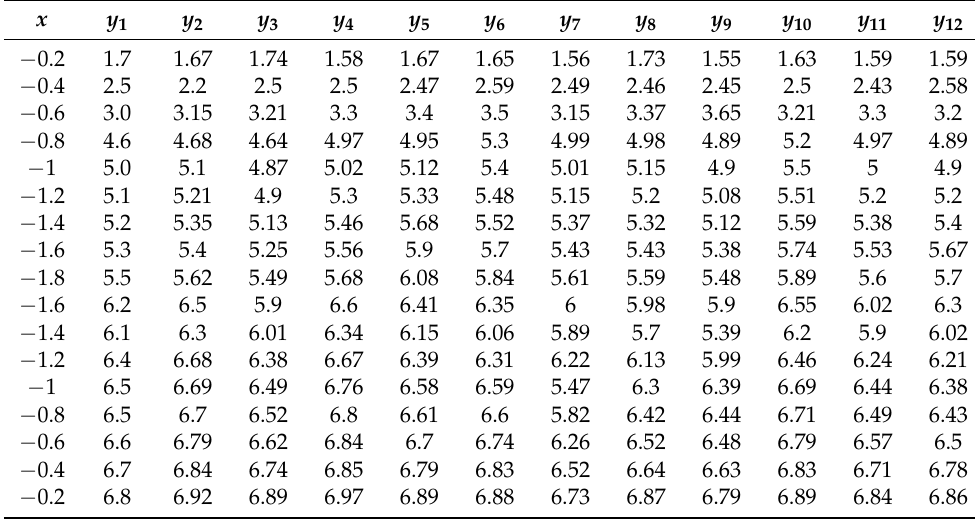
Table A1. The coordinates ( x , y ) of the ultrasound data points for the shape of the vitreous for 12 patients (part